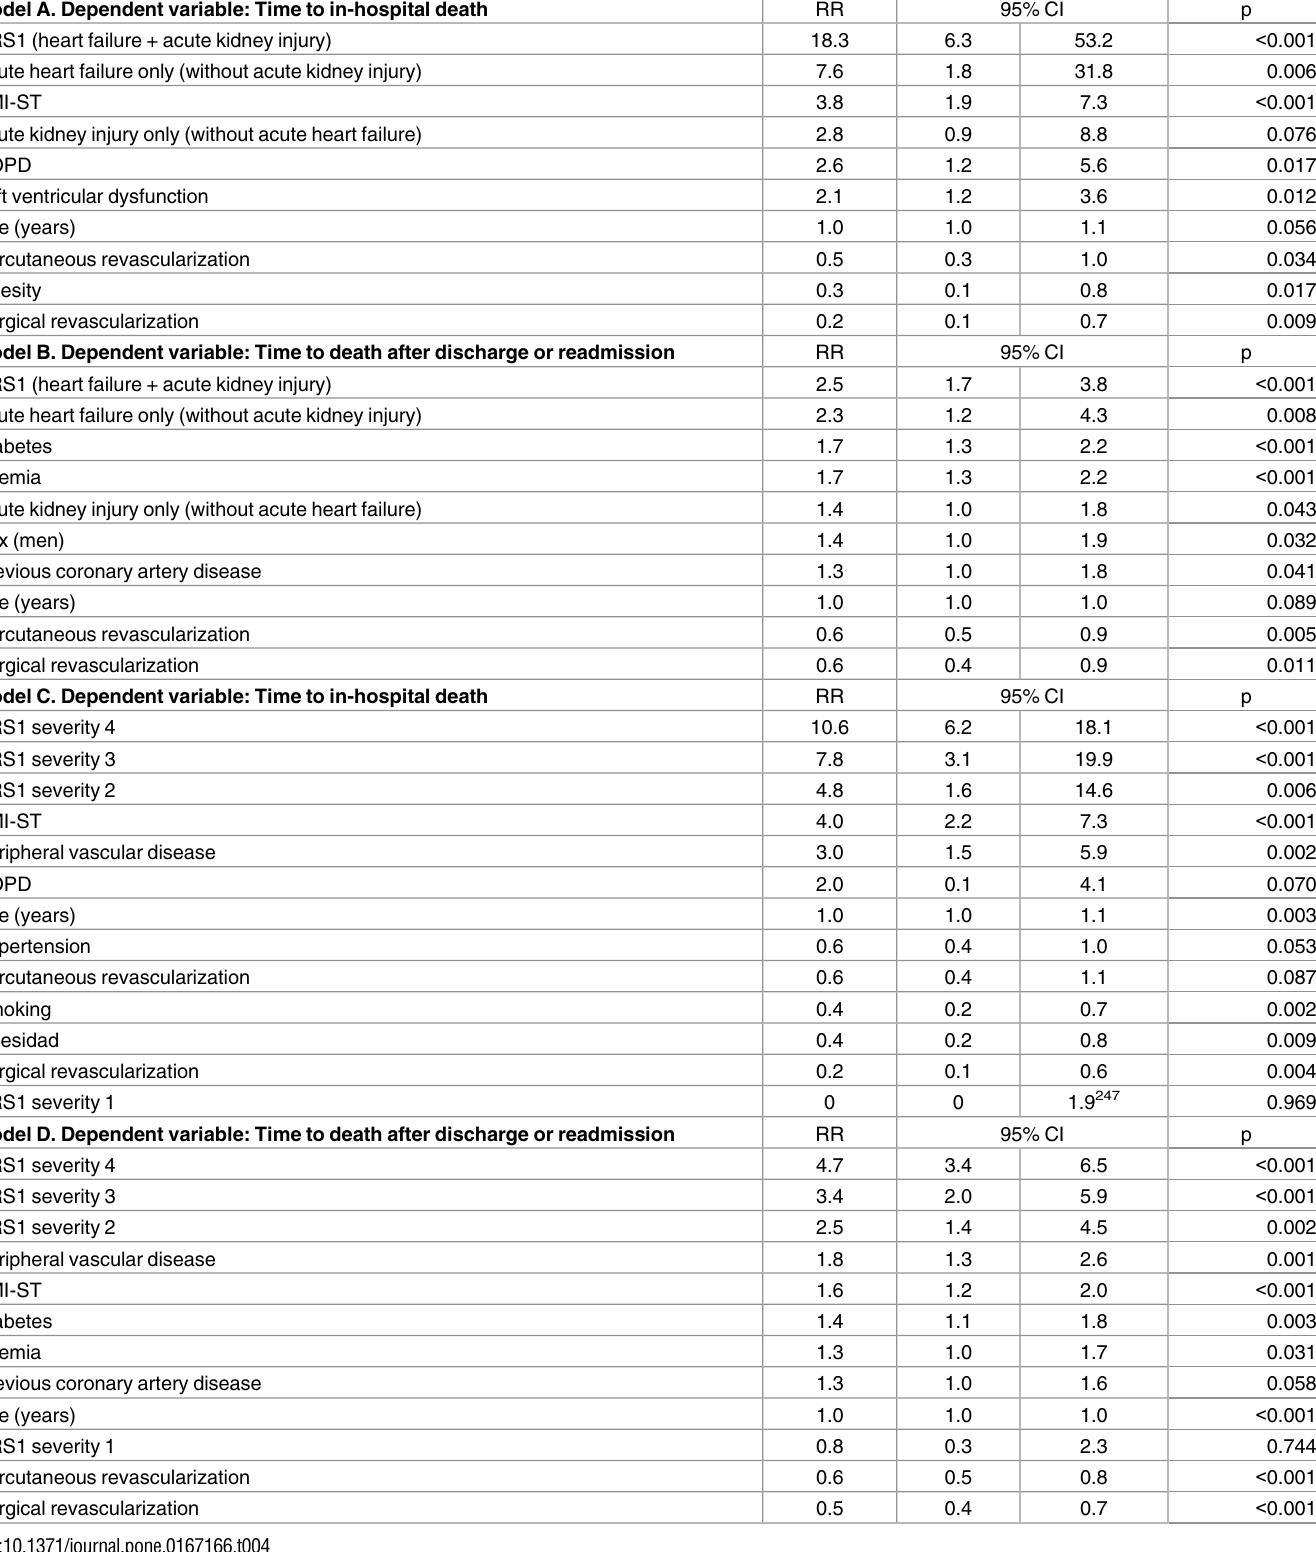
Table 4. Models A and B adjust the associated risk of CRS1 for the two events studied. Models C and D adjust the severity of CRS1. Only the variablesthat remainedin each model are shown. Model A. Dependent variable: Time to in-hospital